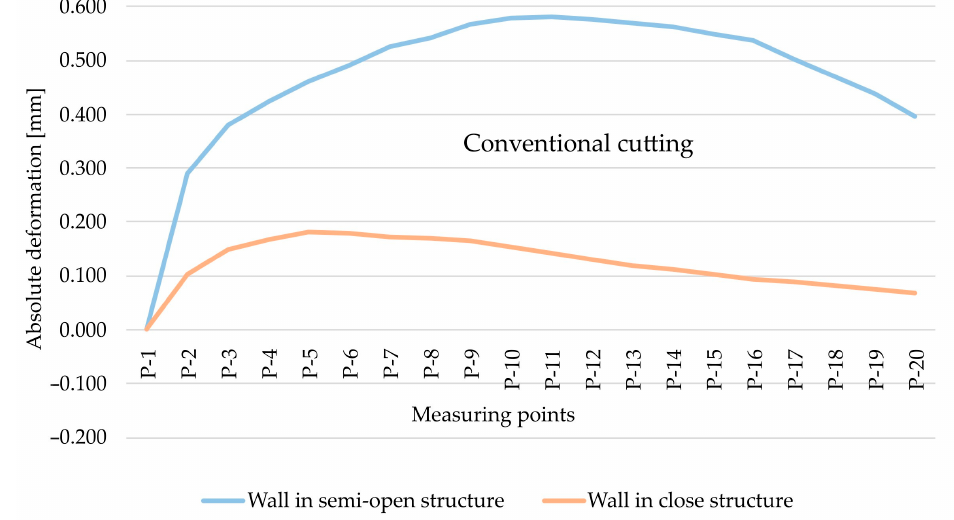
Figure 9. The comparison of absolute deformation for individual measurement points depending on the geometry of the thin-walled sample for conventional cutting and for the EN AW-7075 T651 aluminium alloy.